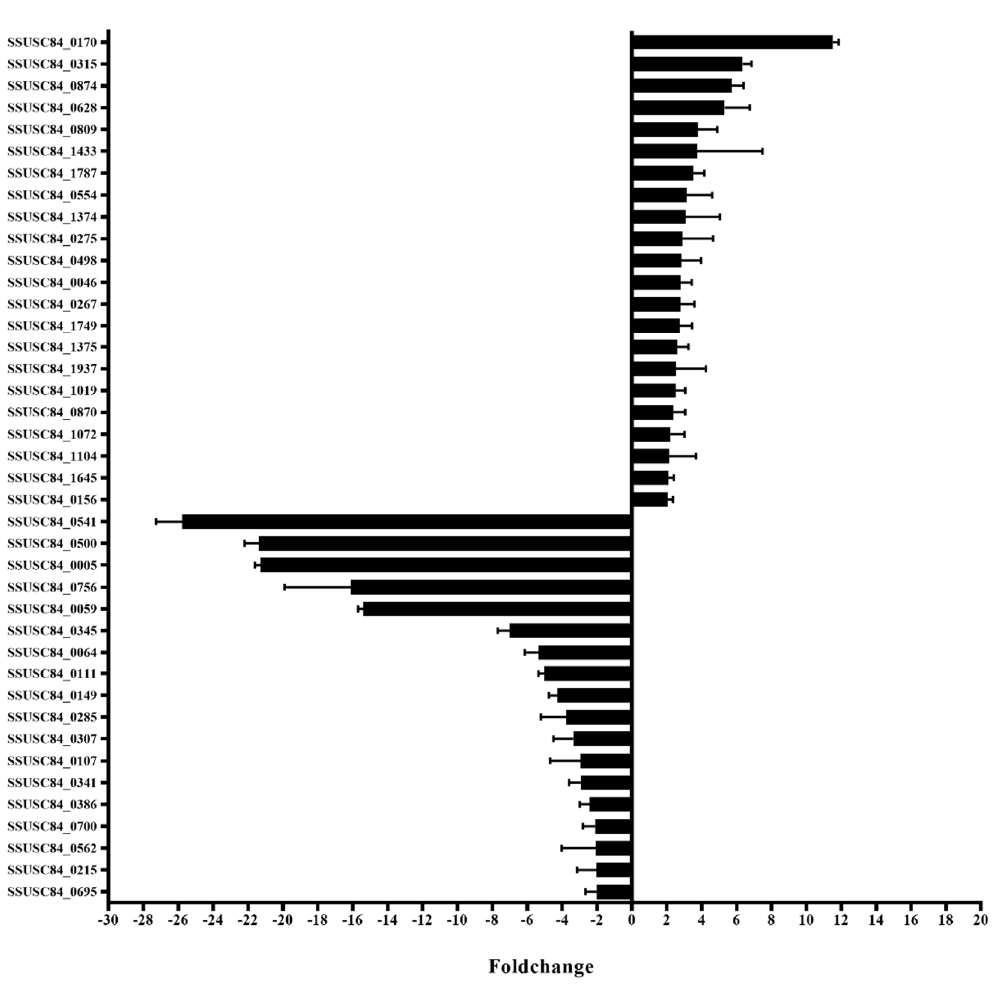
Figure 1. In vivo induction assay for the analysis of transcriptional regulators in the genome of Streptococcus suis SC84 that are differentially expressed (fold-change ≥ 2 or ≤ − 2). Ten specific pathogen-free C57BL/6 mice were intraperitoneally infected with 5 × 10 8 CFUs of the WT strain. Mice were sacrificed and dissected after 6 h. The spleens were harvested, and the bacteria were isolated. As a control, 5 mL of in vitro WT strains were collected when the OD was 0.6, representing mid-stationary phase. Furthermore, the bacterial RNA was extracted, and qRT-PCR was performed.